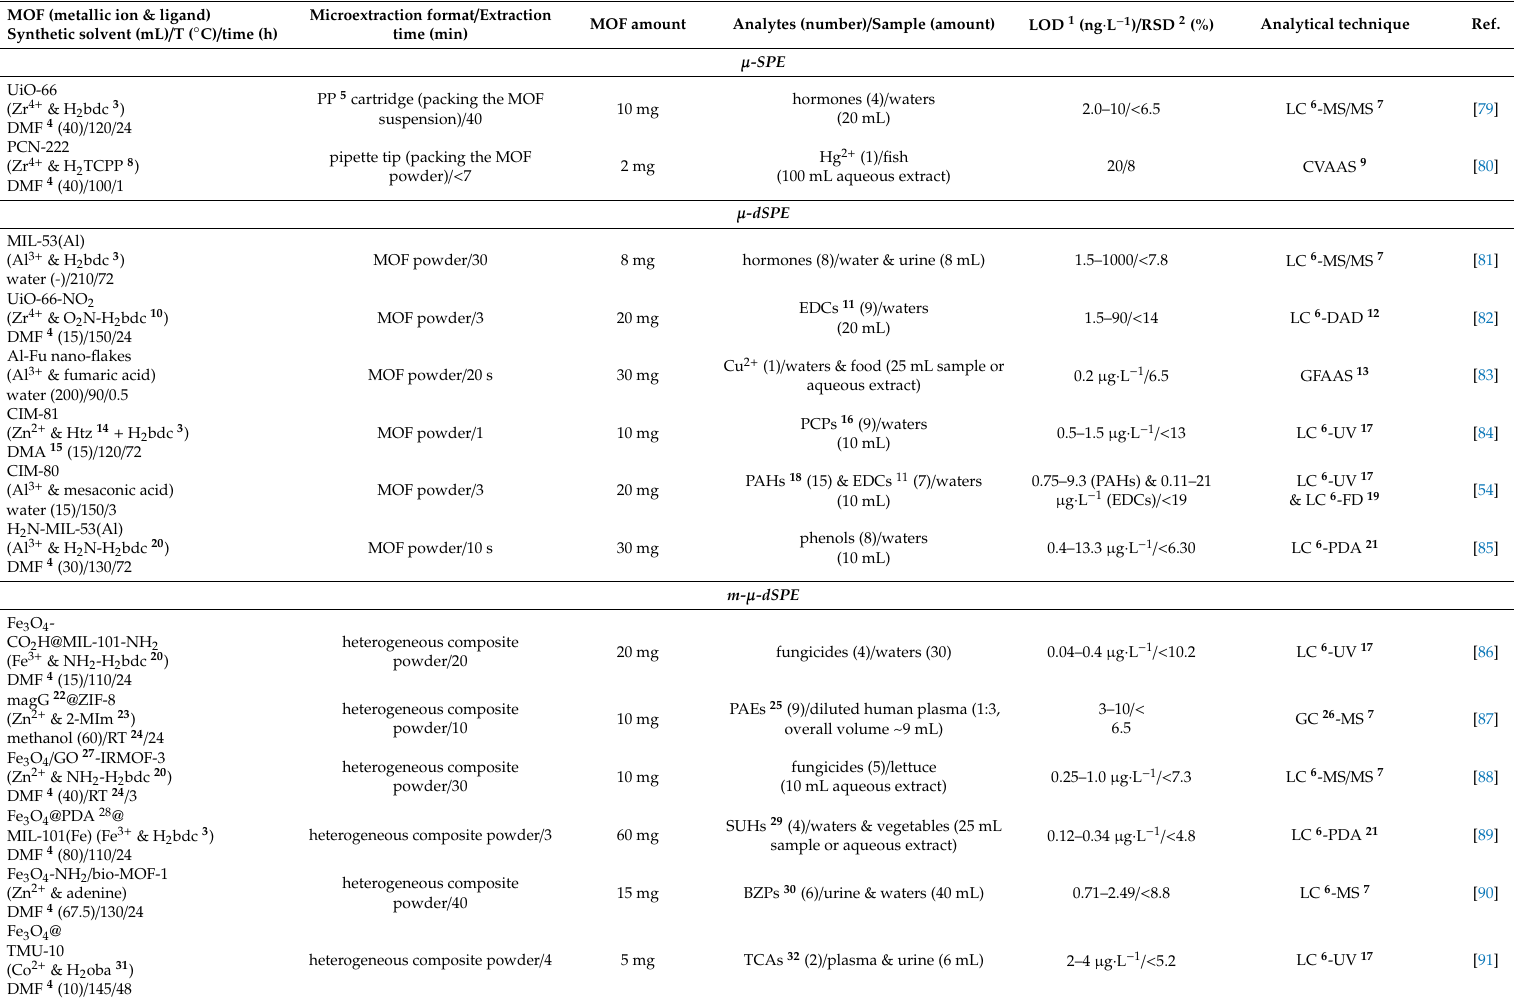
Table 2. Representative examples of environment-friendly microextraction methods incorporating MOFs as novel sorbents in the period